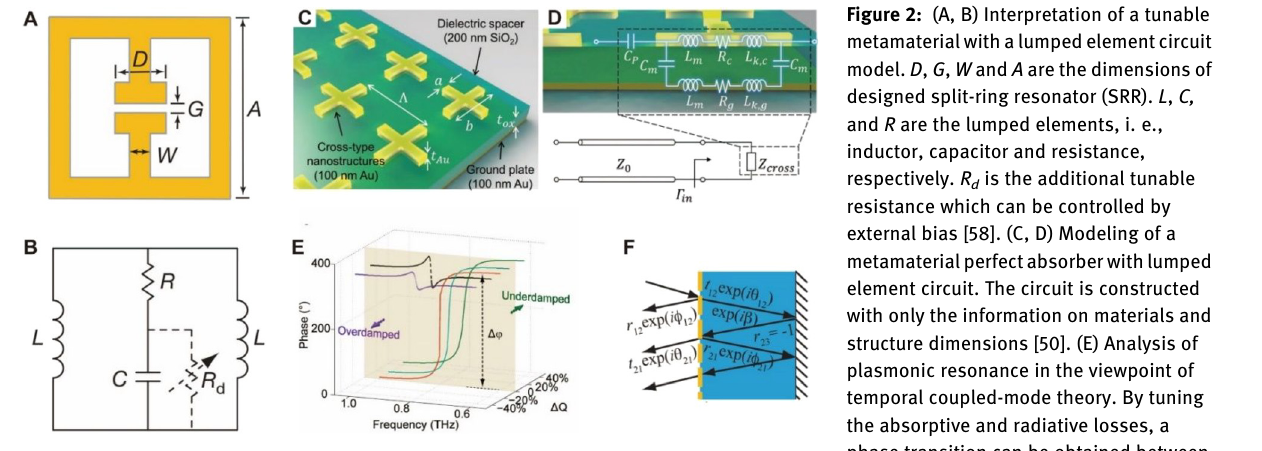
measured results. Figure 2C, D show an example of meta- material perfect absorber which can be accurately modeled with an equivalent circuit model by considering an effec- tive length and mutual coupling between neighboring el- ements [50].